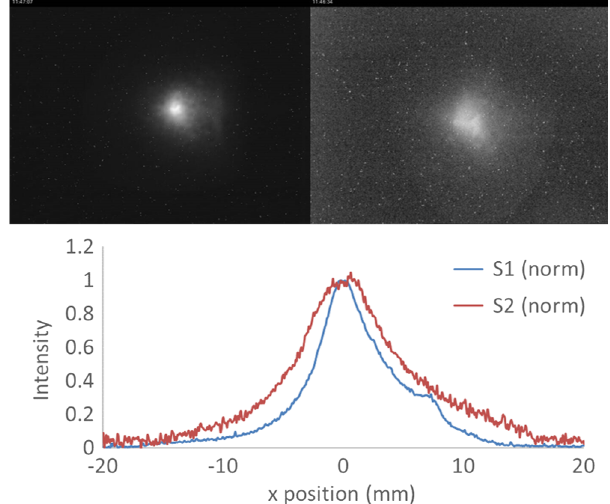
FIG. 18. Beam images on screens S1 and S2 and corresponding transverse beam profiles.